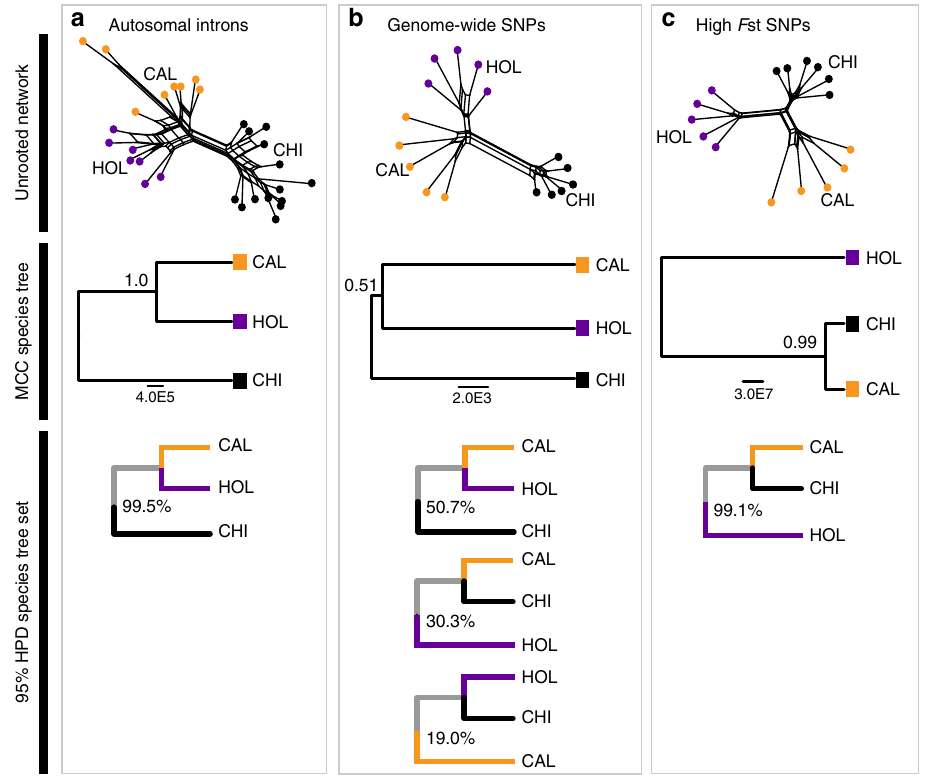
Fig. 5 Discordant phylogenetic signals in the nuclear genome. Unrooted Neighbour-Net trees and species trees inferred for the three lineages of North American ravens — Chihuahuan Ravens (CHI, black), pure Holarctic (HOL, purple) and California (CAL, orange) — estimated from three nuclear data sets: a autosomal introns, b all genome-wide SNPs, c high F ST SNPs between California and Holarctic lineages ( n = 131 SNPs with F ST > 0.2). For species trees, we show the maximum clade credibility (MCC) species tree inferred from all post-stationarity trees, and the percentage of trees matching each topology contained within the 95% HPD set of trees in each data